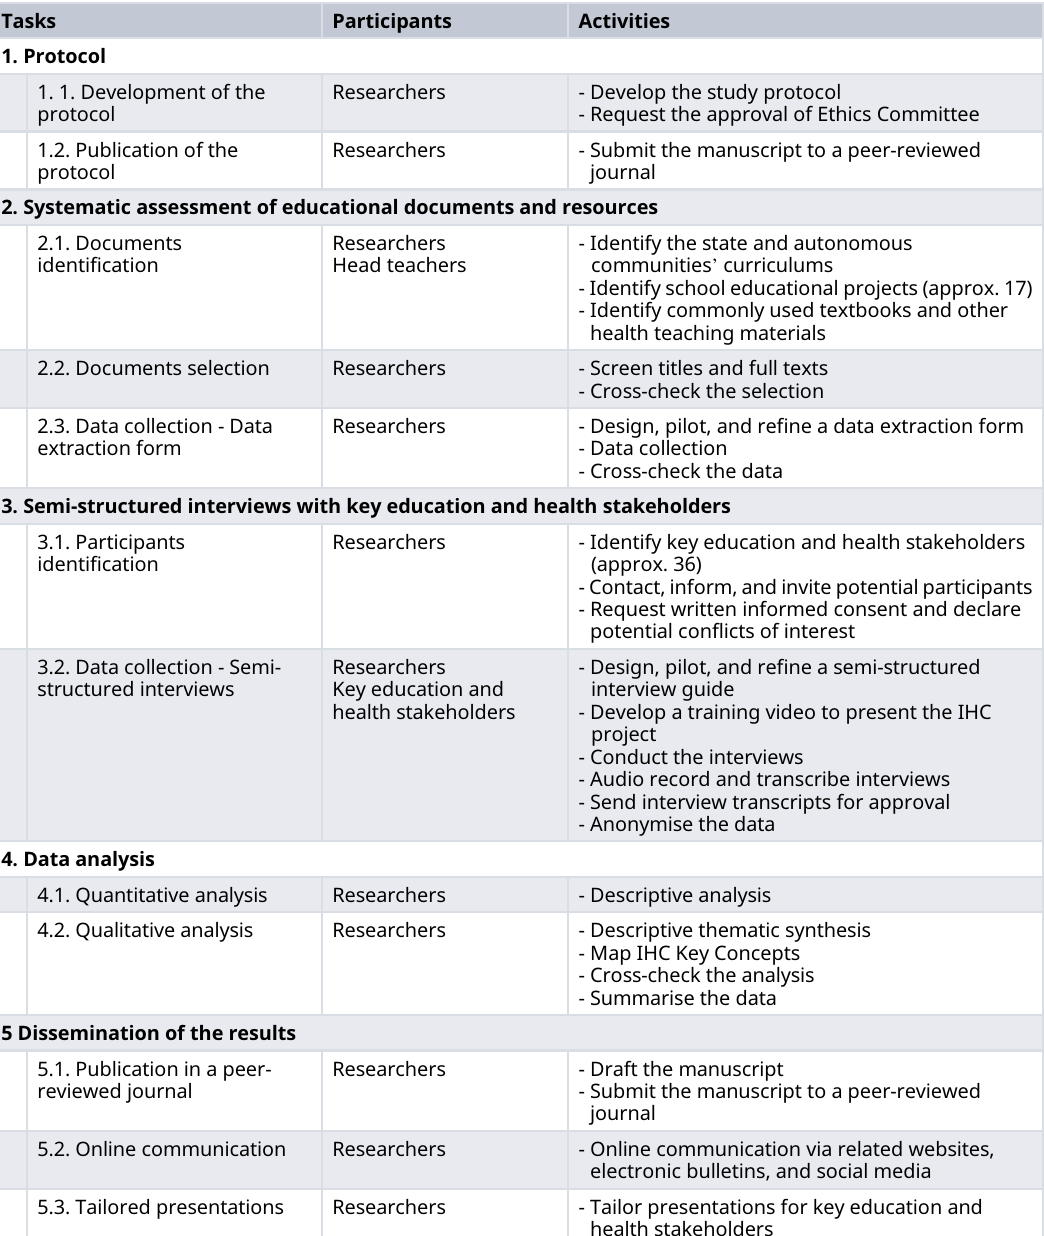
Table 2. Tasks of the study.